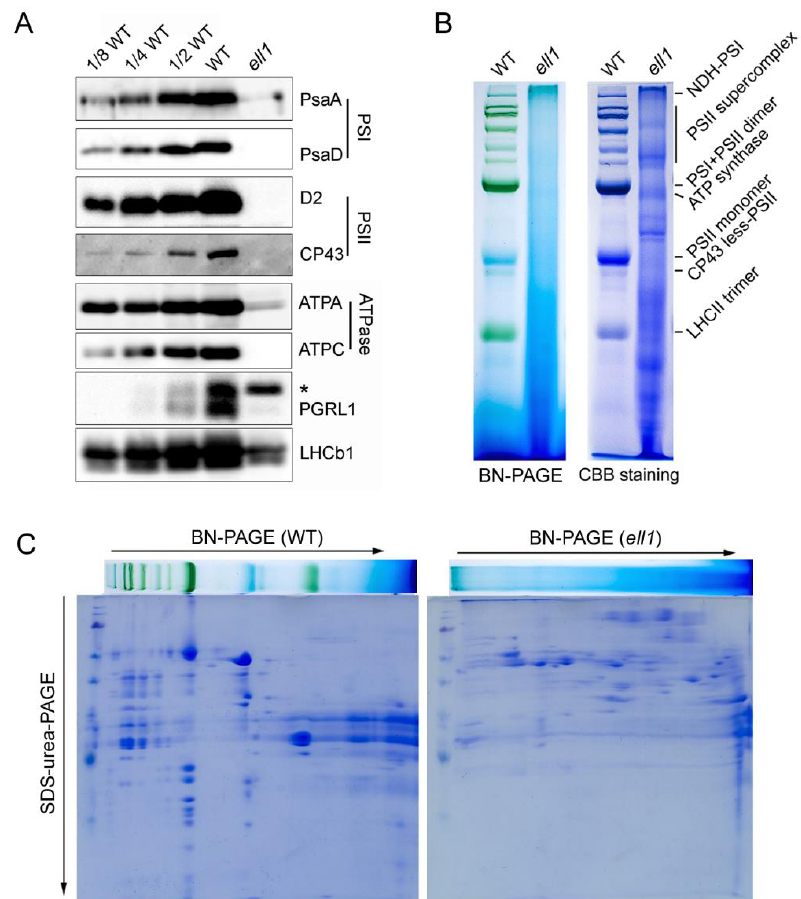
Figure 2. Accumulation of photosynthetic proteins is reduced in ell1 . ( A ) Immunoblot analysis of thylakoid proteins. Thylakoid proteins were extracted from three-leaf stage seedlings of WT and ell1 and loaded with equal total proteins. * Non-specific signal. ( B ) BN-PAGE analysis of thylakoid membrane protein complexes. Thylakoid membranes were isolated and separated by 5–12% BN- PAGE, the gels stained with Coomassie Brilliant Blue (CBB) are shown on the right. NDH-PSI indicates the NDH-PSI supercomplex. ( C ) Two-dimensional BN/SDS-PAGE separation of thylakoid protein complexes. Thylakoid complexes separated by BN-PAGE in the first dimension ( B ) were subjected to denaturing SDS-urea-PAGE. Proteins were stained with CBB; the identities of relevant proteins are indicated.